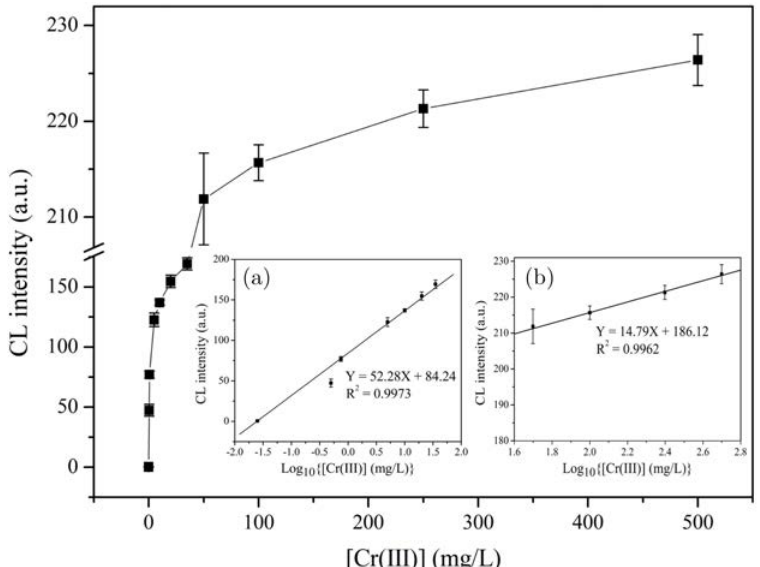
Fig. 6. Calibration curve for GCF-CL determination of Cr(III) under optimal conditions. The inset shows the linear relationship between the GCF-CL intensity and the logarithm of Cr(III) concentration in the range of 0.025 – 35 mg/L (a) or 50 – 500 mg/L (b). Assay conditions: ½ EDTA (cid:5) ¼ 1 mM; pH of substrate solution/test solution ¼ 11 : 50/3.00; ½ luminol (cid:5) ¼ 9 mM; ½ H 2 O 2 (cid:5) ¼ 0 : 4 M; ½ KBr (cid:5) ¼ 0 : 75 M; inclination angle ¼ 30 (cid:2) ; volume of substrate solution/test solution ¼ 30 (cid:2) L/30 (cid:2) L. The error bar is the standard error from eight independent